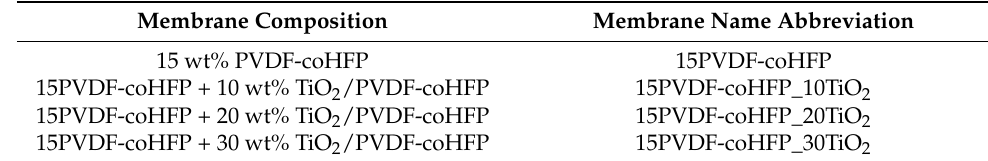
Table 1. Name abbreviation of the membranes tested in this work. Membrane